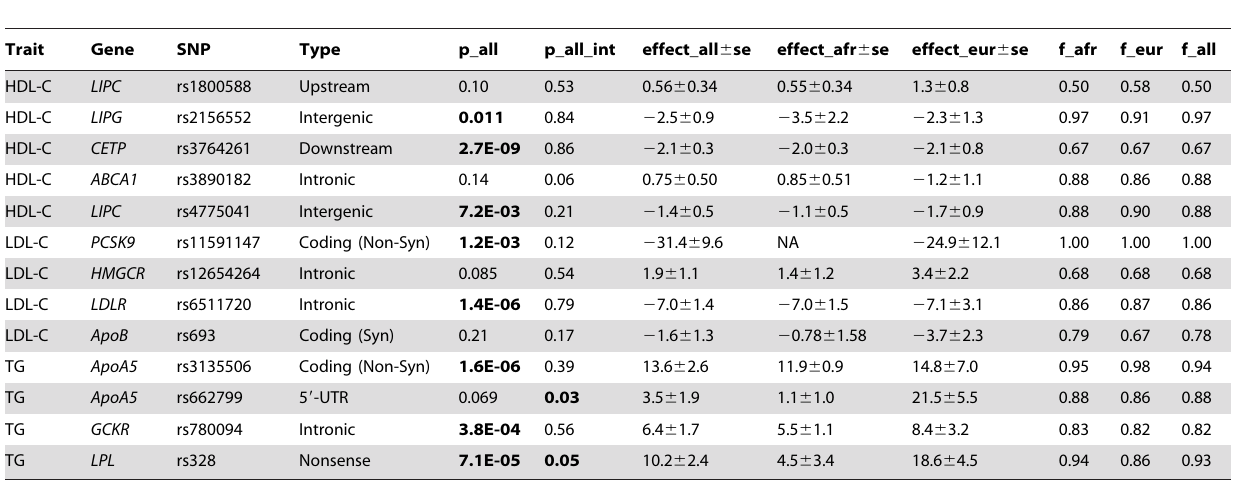
Table 6. Comparison of association of validated SNPs with lipid and cholesterol phenotypes in JHS, JHS-AFR-2 LPL and JHS-EUR- 2 LPL